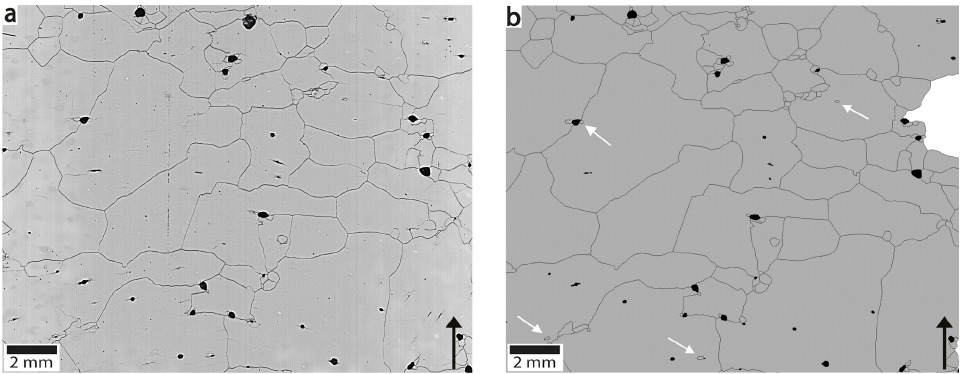
Figure 3. Reflected LM image (a) and the segmented image (b) of an ice core section at 756m depth. The black arrows indicate the top of the ice core. White arrows indicate examples of artifacts with a diameter < 0 . 3mm that were not included in the grain size data. Images taken from Kipfstuhl (2010) (https://doi.pangaea.de/10.1594/PANGAEA.743296) and Binder et al.